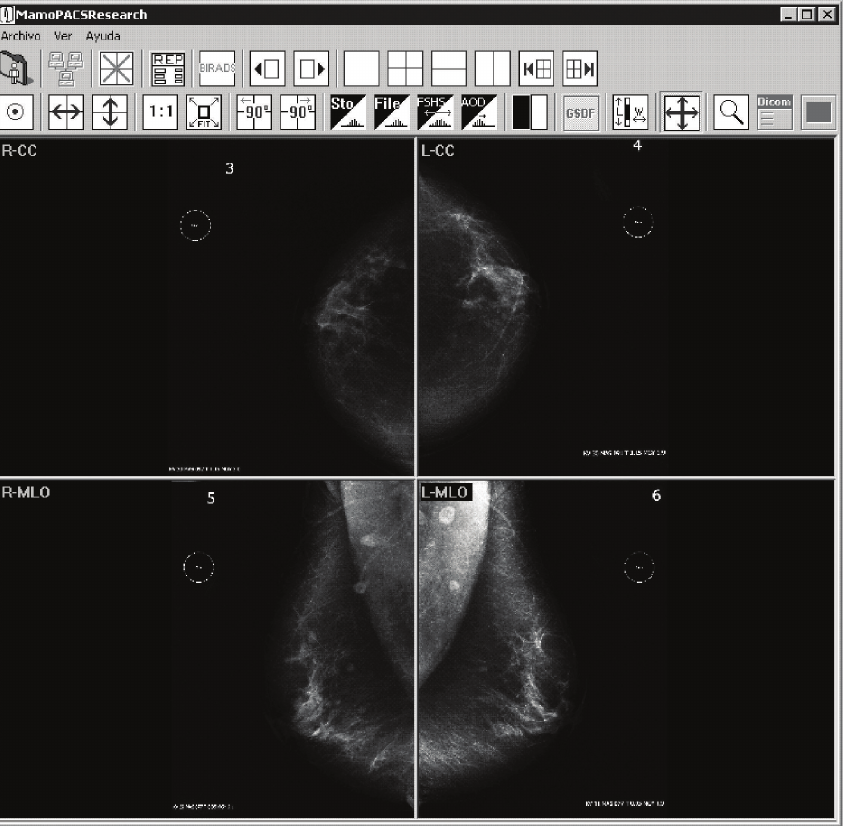
Figure 2: Interpretation software. This software is compliant with the Digital Imaging and Communication in Medicine (DICOM)